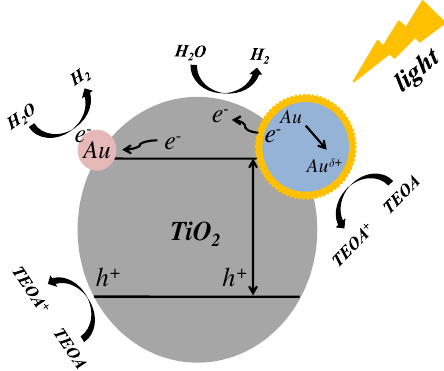
Figure 9. Schematic diagram for possible mechanism of dual particle-size AuNPs/TiO 2 composites for H 2 evolution.